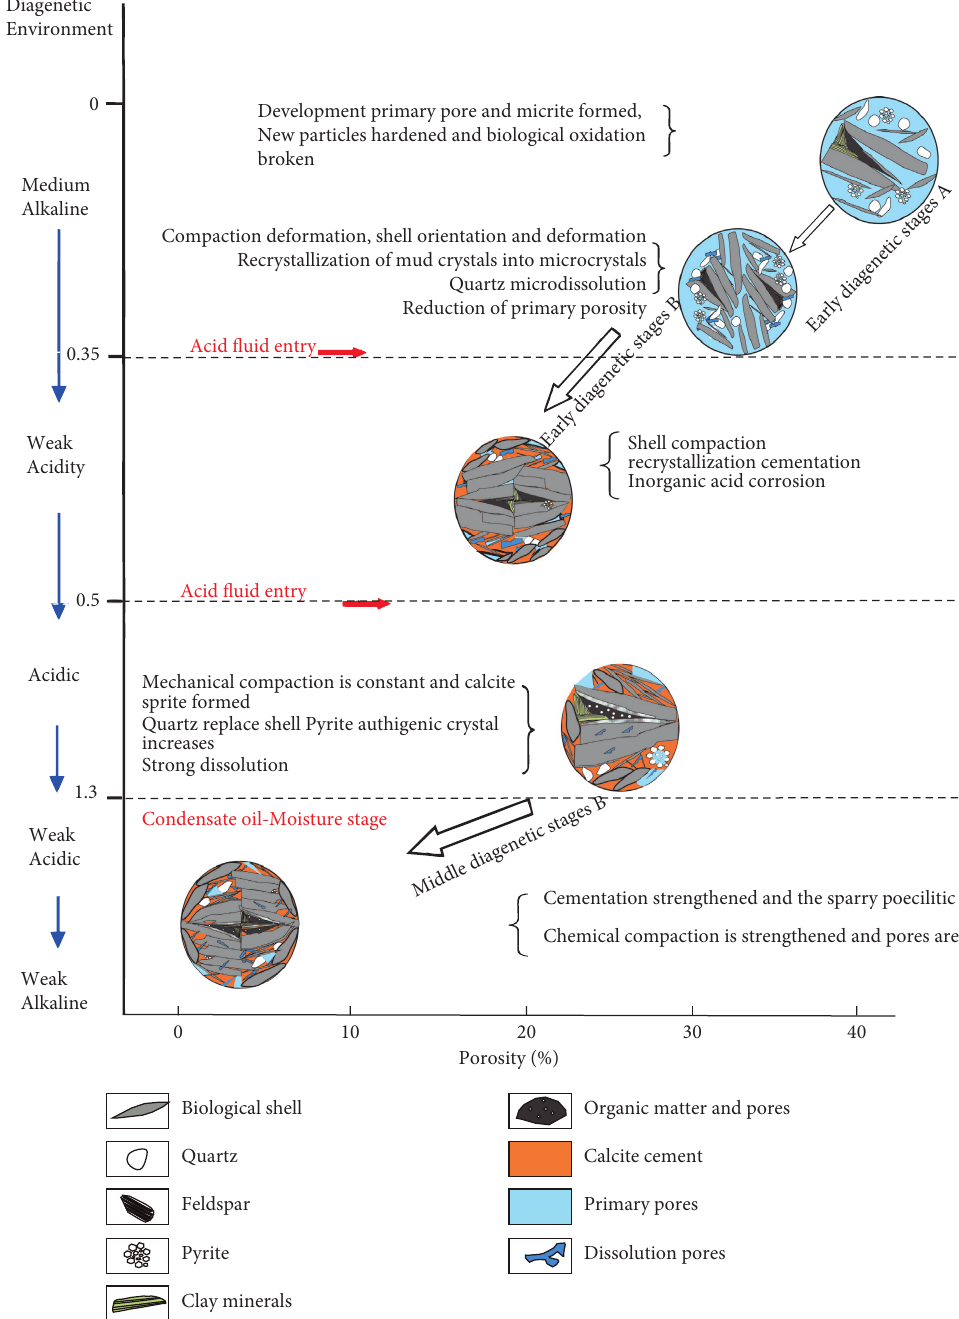
Figure 11: Diagenesis and pore evolution model of limestone in Da’anzhai Member in northern